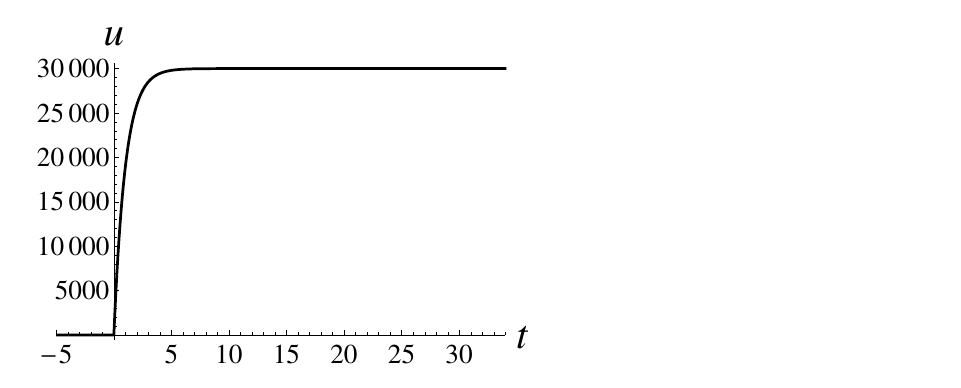
Figure 1. Solution to Equation (2) with initial conditions from S + in the case b > 0 and d > 0. Values of parameters: λ = 10 4 , T = 5, p L = − 1, p R = 2, b = 2, d =